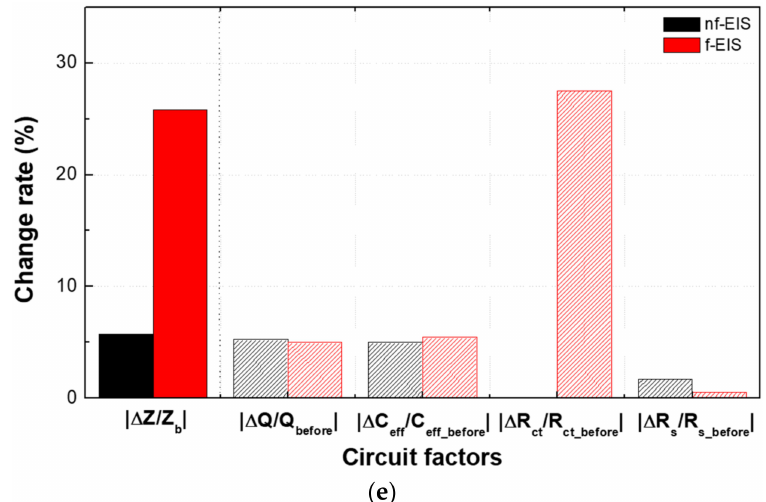
Figure 6. ( a , b ) Measured impedance spectrum (10 Hz–100 kHz) of nf-EIS and ( c , d ) f-EIS. ( e ) Percentage change of impedance magnitude at 100 Hz and equivalent circuit factors of the two EIS-sensors (The equivalent circuit fitting residual, r 2 = 0.9802 for nf-EIS and r 2 = 0.9137 for